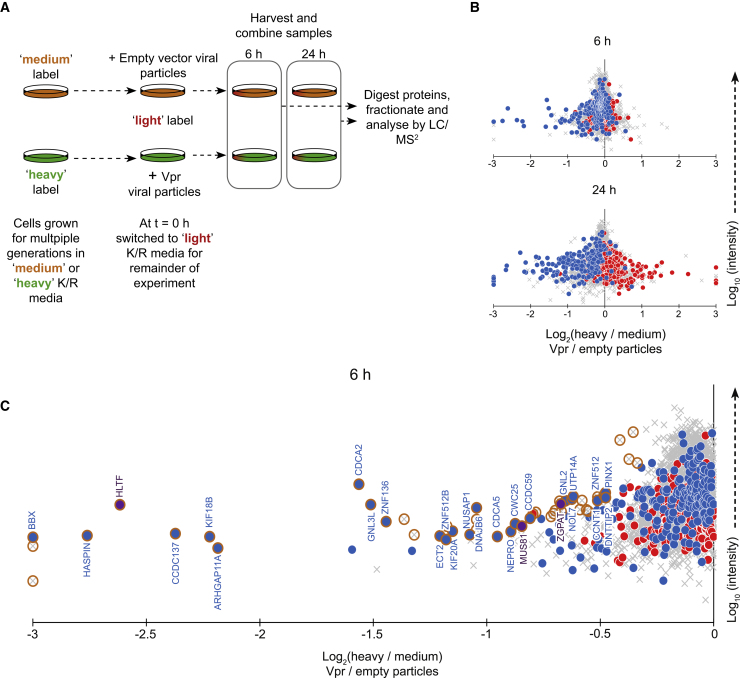
Pulsed SILAC Method to Identify Direct Targets for Vpr-Mediated Degradation(A) Graphical summary of the pulsed SILAC experiment.(B) Scatterplots showing the changes to protein stability of proteins after 6 or 24 h of exposure to a Vpr-bearing lentivirus compared with a control lentivirus, with previously defined groups of Vpr-depleted (blue) and -increased (red) proteins highlighted.(C) Expanded view of proteins degraded within 6 h of Vpr exposure. Significantly degraded (significance B [Sig.B] < 0.01) proteins are highlighted in gold. The previously described Vpr targets HLTF, MUS81, and ZGPAT are shown in purple.